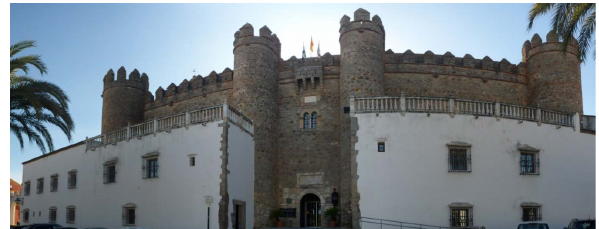
Figure 3. A modern panoramic view of the convent of Santa